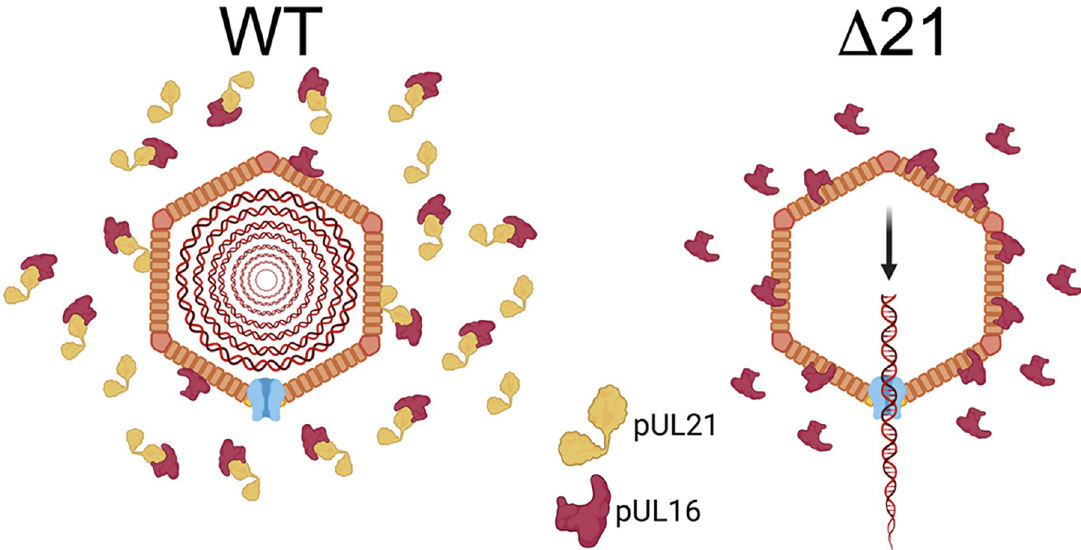
Fig 8. Possible mechanism accounting for impaired viral genome retention in the absence of pUL21. In the nuclei of cells infected with WT strains, sequestration of pUL16 by pUL21 prevents pUL16 from associating with nucleocapsids. However, in the absence of pUL21, pUL16 more readily associates with nucleocapsids and hinders genome retention within Δ 21 capsids. The figure suggests that viral genomic DNA vacates Δ 21 capsids via the portal, however, it may be that genomes escape these capsids at sites other than the portal. Figure created with